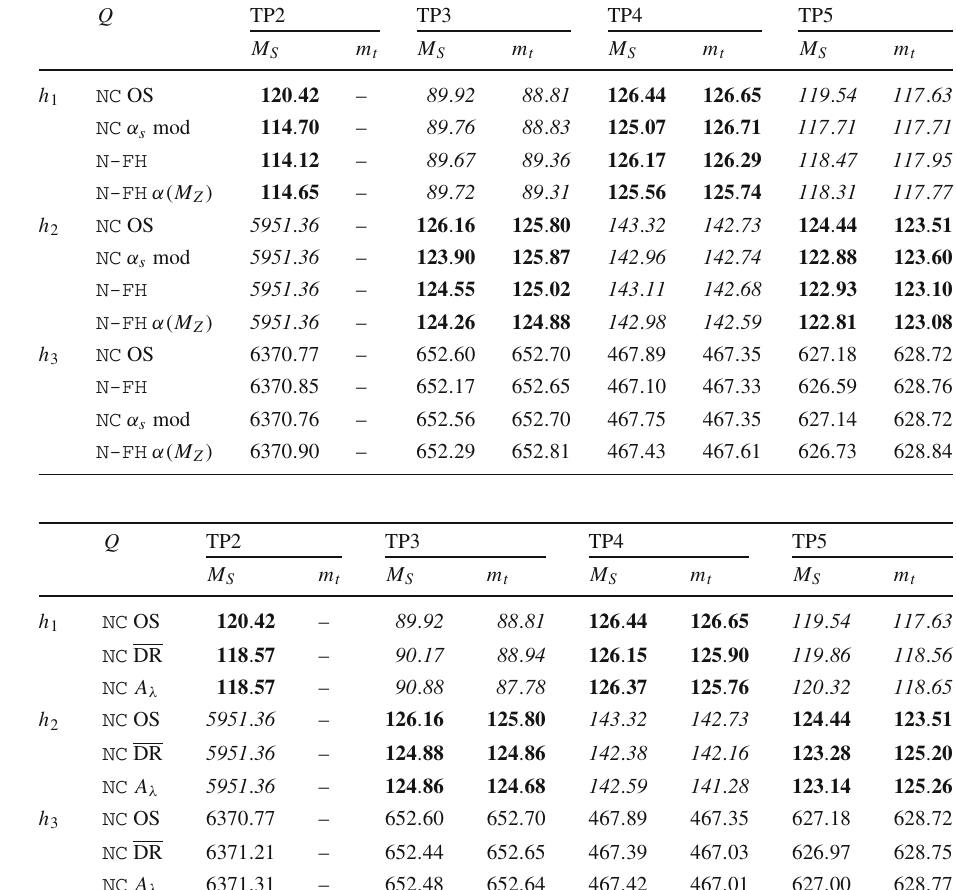
the mass predictions for the CP -even scalars when using the indicated versions of NMSSMCALC and NMSSM-FeynHiggs as specified in Sects. 5.1 and 5.4